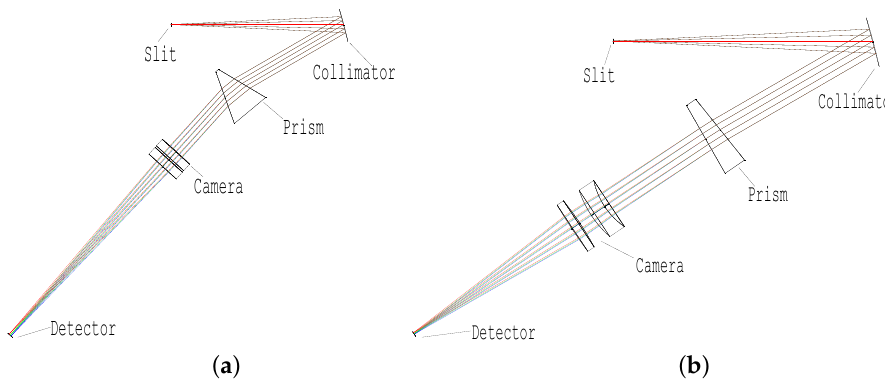
Figure 9. Layouts of ( a ) CH1 and ( b ) CH2. Two independent channels (CH1 and CH2) are connected to dichroic-system slits. The focused beams from the slits are shaped into parallel beams by collima- tors and dispersed to spectra by prisms. Lastly, spectra are focused on detectors by lenses of cameras. CH1 and CH2 cover different wavelengths with varying spectral resolutions.